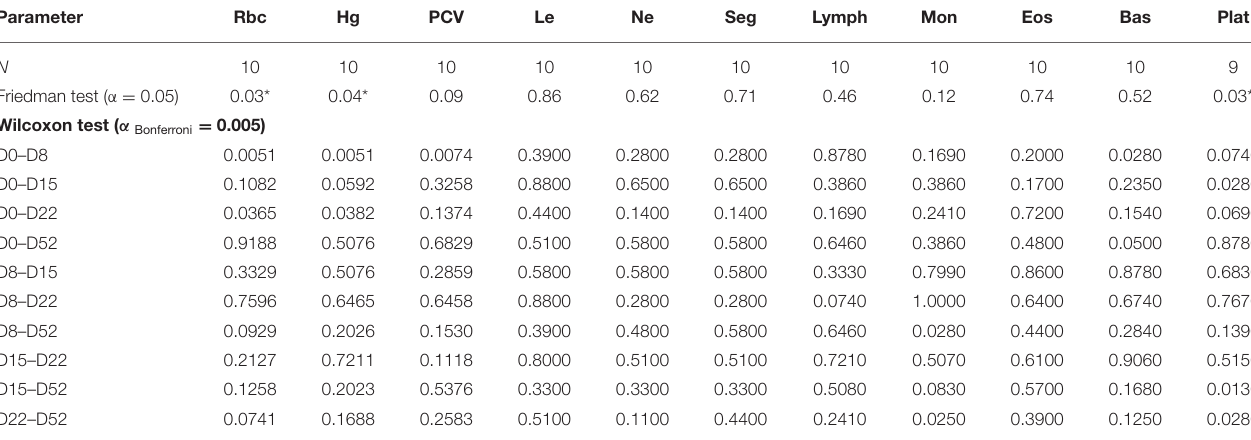
TABLE 5 | Complete blood count parameters and respective p values (Friedman and Wilcoxon